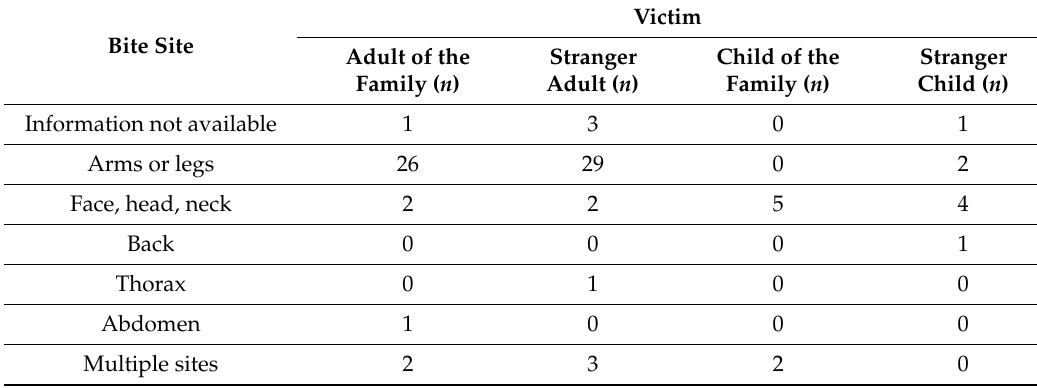
Table 18. Comparisons between the type of victim and bite site in dog–human aggression episodes.